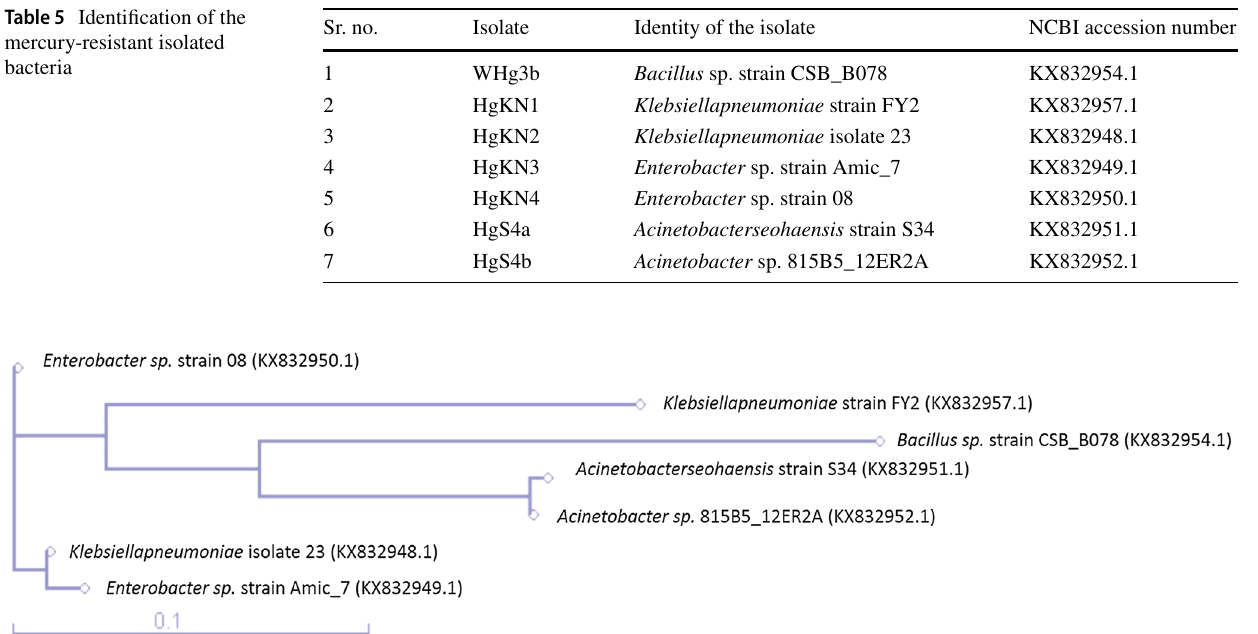
Fig. 3 Phylogenetic tree of the isolated mercury-resistant bacteria Table 6 Minimum inhibitory concentration of the bacterial isolates